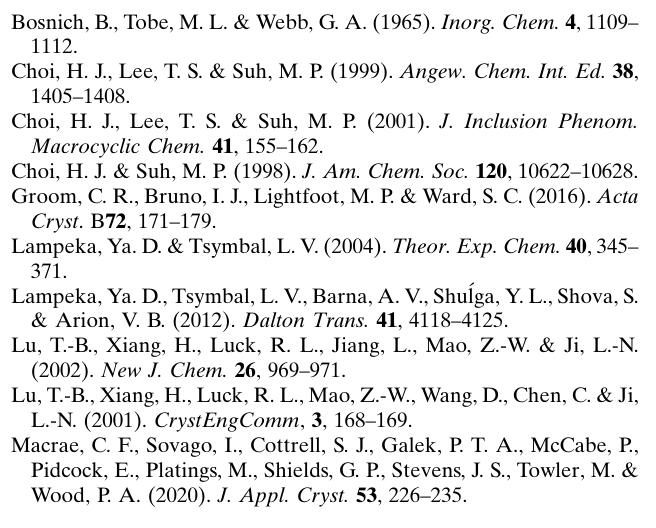
(ring H atoms), 0.97 A˚ (methylene H atoms), N—H distances of 0.98 A˚ , O—H distances of 0.82 A˚ (protonated carboxylate group) and 0.85 A˚ (water molecules) with U (H) values of iso or 1.5 U times those of the corresponding parent 1.2 U eq eq atoms. SQUEEZE calculations indicate the presence of eight water molecules of crystallization per asymmetric unit of I .